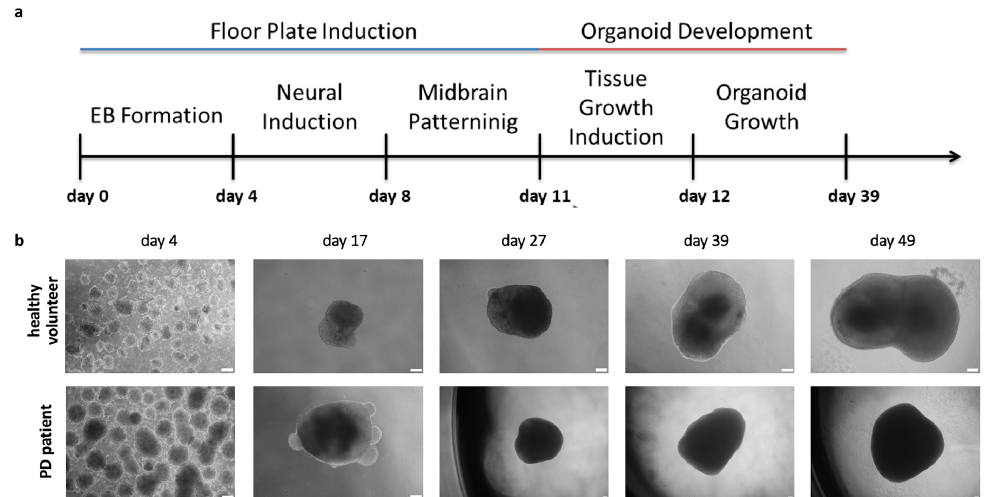
Figure 3 . Scheme of organoids generation and morphology of organoids from healthy volunteer and PD patient. ( a ) Diagrams presenting strategy of generation of midbrain organoids. ( b ) Morphology